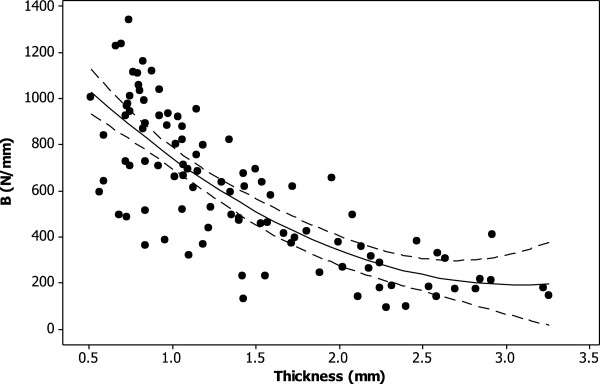
Thickness dependency of B (see equation 1) for knee joint cartilage. A second order polynomial curve (equation 5) was fitted to the experimental data (R2 = 63%; p < 0.05) as shown (solid line). The 95% confidence intervals are also included (dashed line).